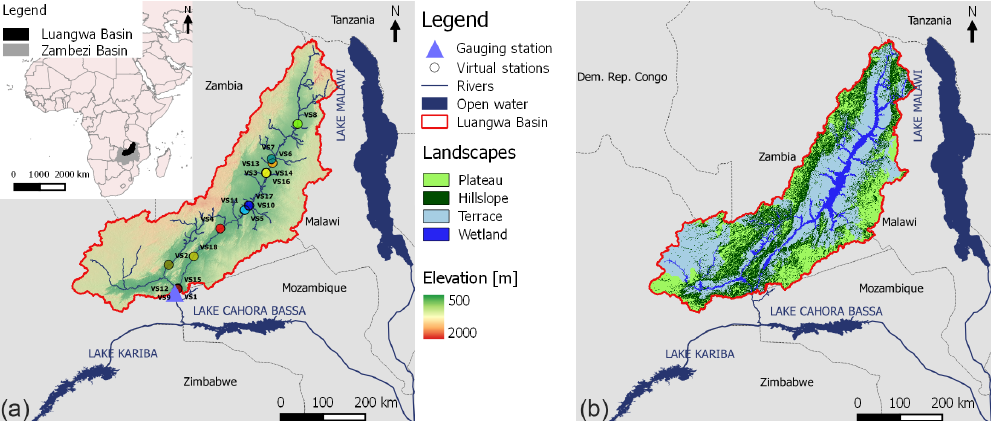
Figure 1. (a) Elevation map of the Luangwa River basin in Zambia including the Great East Road Bridges river gauging station and the locations of the 18 virtual stations (VS 1–VS 18; the red dot is VS 4) with altimetry data used in this study; their colours correspond to those in Fig. 4. (b) Map of the Luangwa River basin with the main landscape types (see Sect. 3.2). Table 1. Gridded data products used in this study. Time period Time resolution Spatial resolution Product name Source Digital elevation map n/a n/a 0.02 ◦ GMTED (Danielson and Gesch, 2011) Precipitation 2002–2016 Daily 0.05 ◦ CHIRPS (Funk et al., 2014) Temperature 2002–2016 Monthly 0.5 ◦ CRU (University of East Anglia Climatic Research Unit et al., 2017) Total water storage 2002–2016 Monthly 1 ◦ GRACE (Swenson, 2012; Swenson and